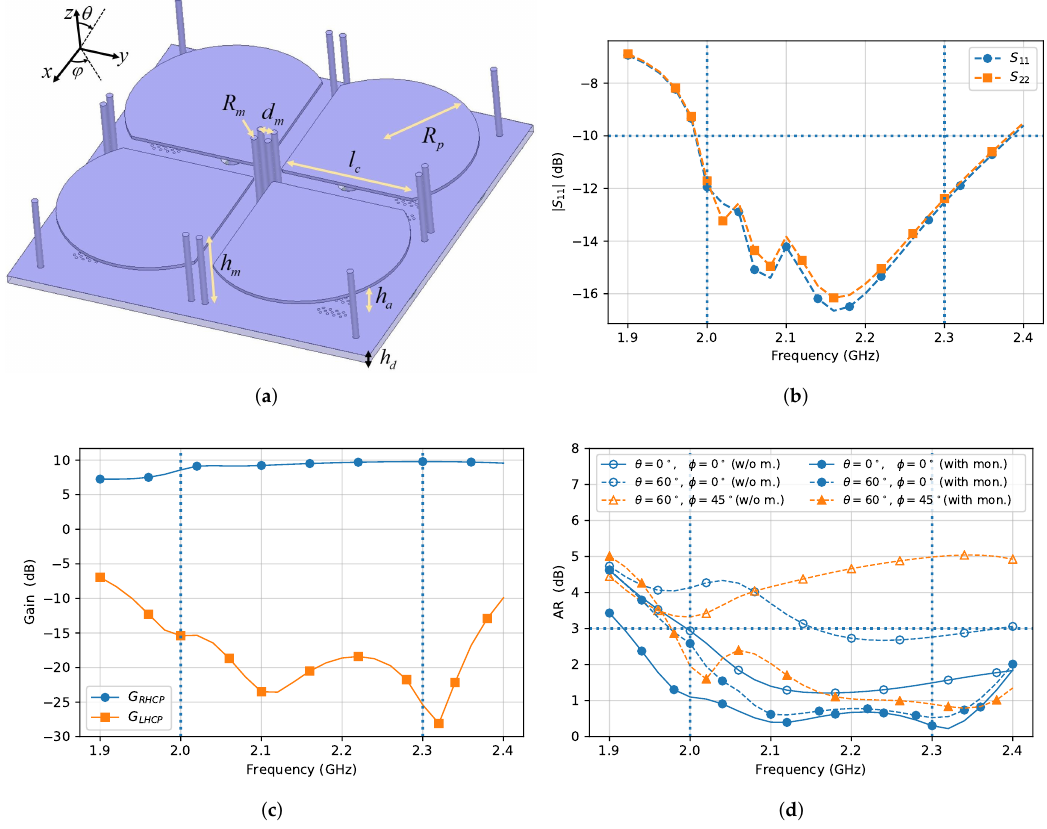
Figure 4. ( a ) Side-view of the proposed 2-by-2 patch array operating in the higher UHF band. ( b ) Reflection coefficient ( S 11 , S 22 ) versus frequency over the operating bandwidth. ( c ) Gain versus frequency over the operating bandwidth. ( d ) Simulated broadside axial ratio ( θ = 0 ◦ ) versus frequency, for different elevation and azimuthal angles. As it is apparent, the monopoles are able to increase significantly antenna polarization